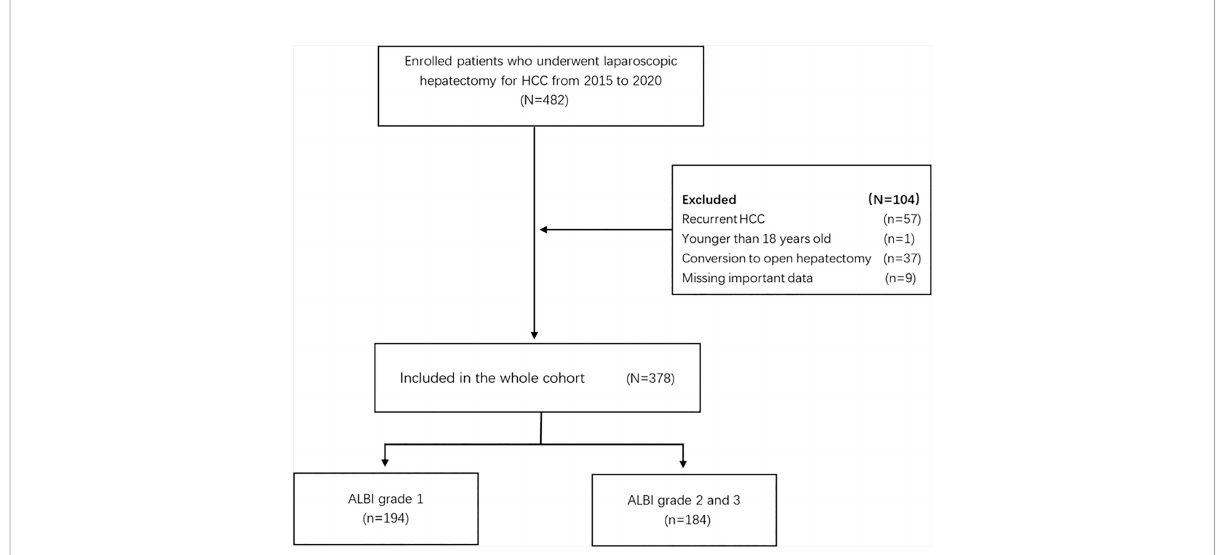
FIGURE 1 Flow chart of participant population. HCC, hepatocellular carcinoma; ALBI, albumin – bilirubin.